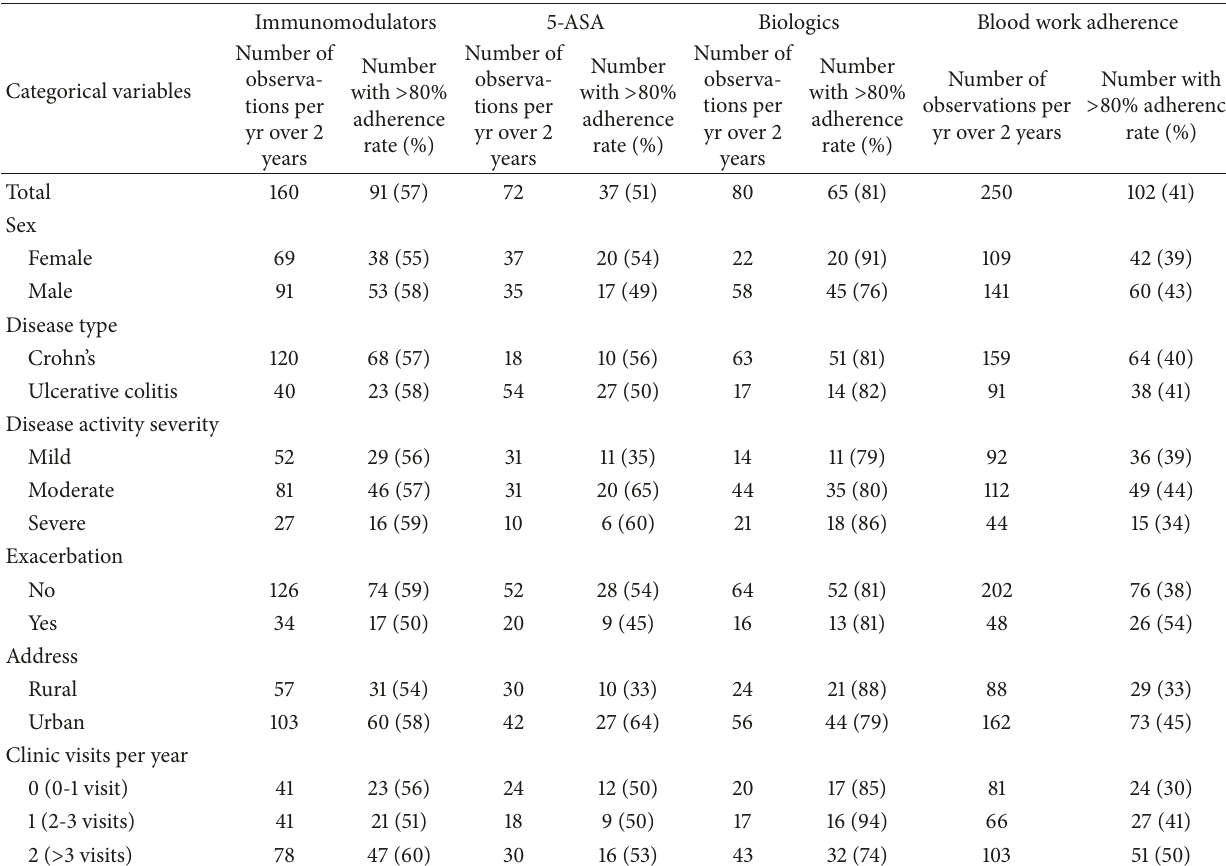
(a) Univaried description of independent categorical variables and